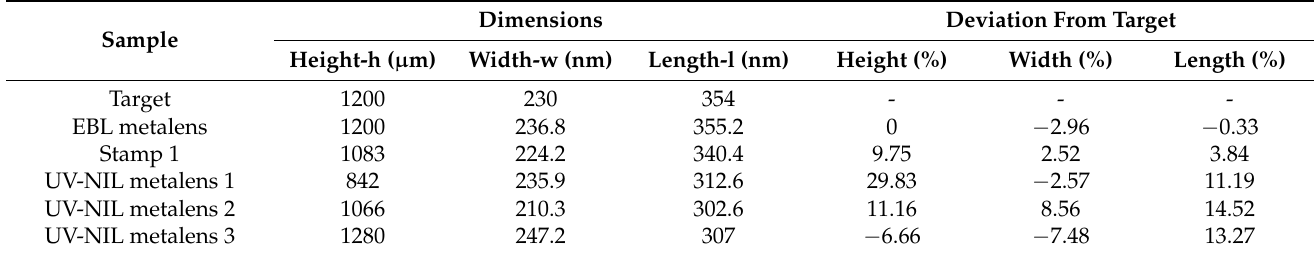
Figure 10. ( a ) Focal spot intensity profile of a metalens made using EBL (blue) and a metalens made using NIL (orange), compared to the theoretical profile for a lens with the designed efficiency (dashed line) for 1550 nm laser light. As discussed in Section 2.1, the less − than − unity efficiency is largely attributed to using a silicon substrate; ( b ) image of the focal spot from the EBL lens; ( c ) optical microscope image of the EBL lens; ( d ) image of the focal spot of the NIL lens, for 1550 nm laser light; ( e ) optical microscope image of the NIL lens with sidelengths 1.5 mm. Note that for the focal spot measurements, a circular 900 µ m aperture was placed in front of the lenses. Table 2. Dimensions of the metalenses